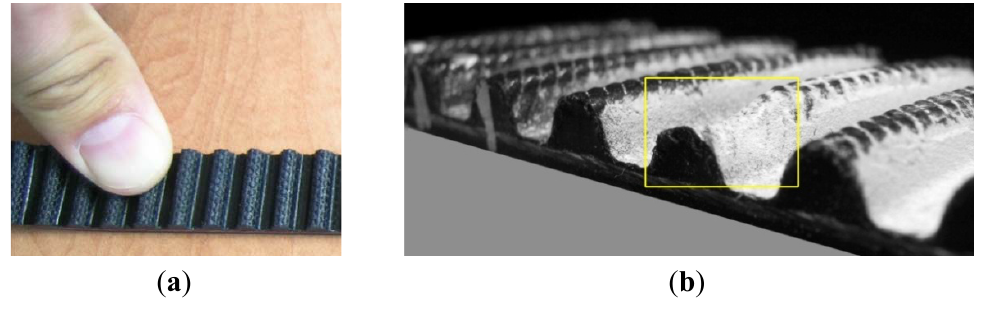
Figure 11. Non-contact 3D digitization system (1-laser profilometer module, 2-laser plane, 3-belt, 4-pulleys, 5-movable cart). ( a ) Photo of the system. ( b ) Schematic diagram of the